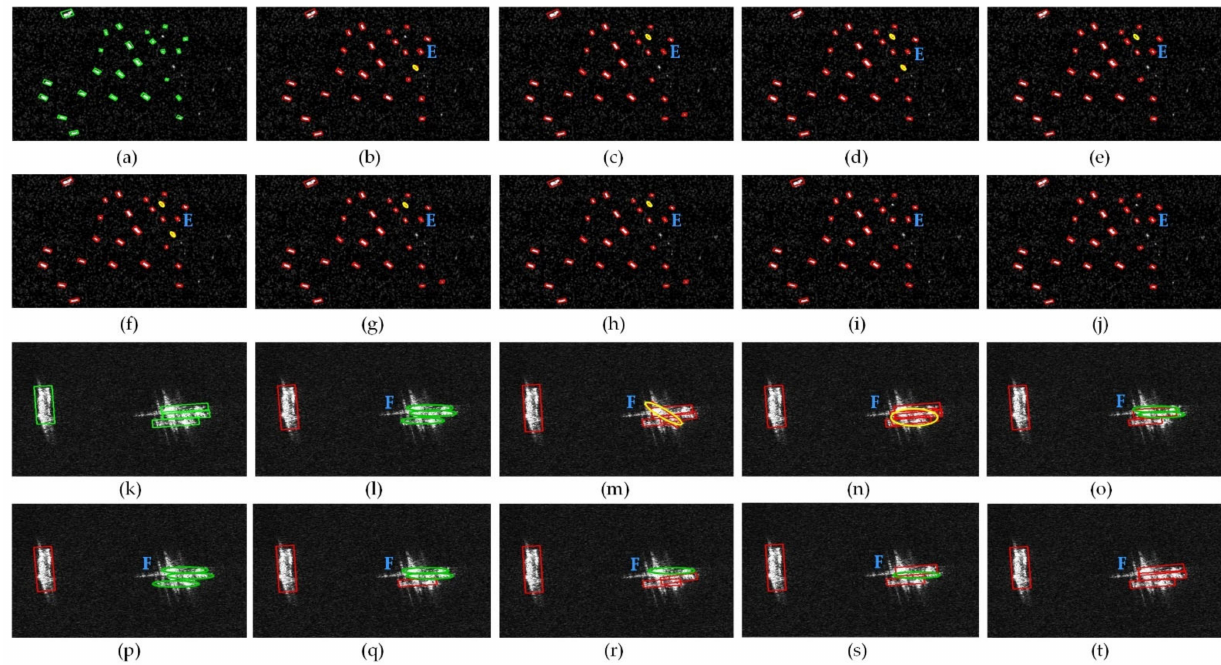
Figure 13. Detection results of different methods in inshore scene. ( a , k ) ground-truths. ( b , l ) results of YOLOv5s-CSL. ( c , m ) results of YOLOv5m-CSL. ( d , n ) results of YOLOv5l-CSL. ( e , o ) results of YOLOv5x-CSL. ( f , p ) results of YOLOv5s-DCL. ( g , q ) results of YOLOv5m-DCL. ( h , r ) results of YOLOv5l-DCL. ( i , s ) results of YOLOv5x-DCL. ( j , t ) results of BiFA-YOLO. Note that the red boxes represent true positive targets, the yellow ellipses represent false positive targets and the green ellipses represent missed targets.